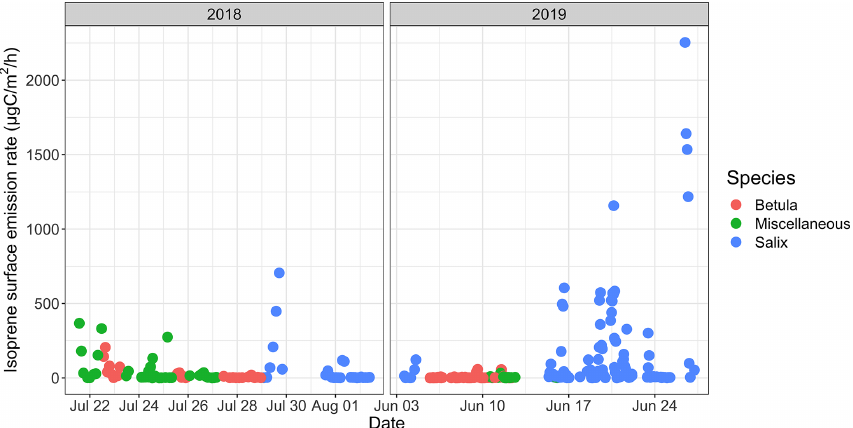
Figure 6. Time series of isoprene surface emission rates (in µgCm − 2 h − 1 ) for different vegetation types. Miscellaneous refers to a mix of different species, including lichens and moss tundra.